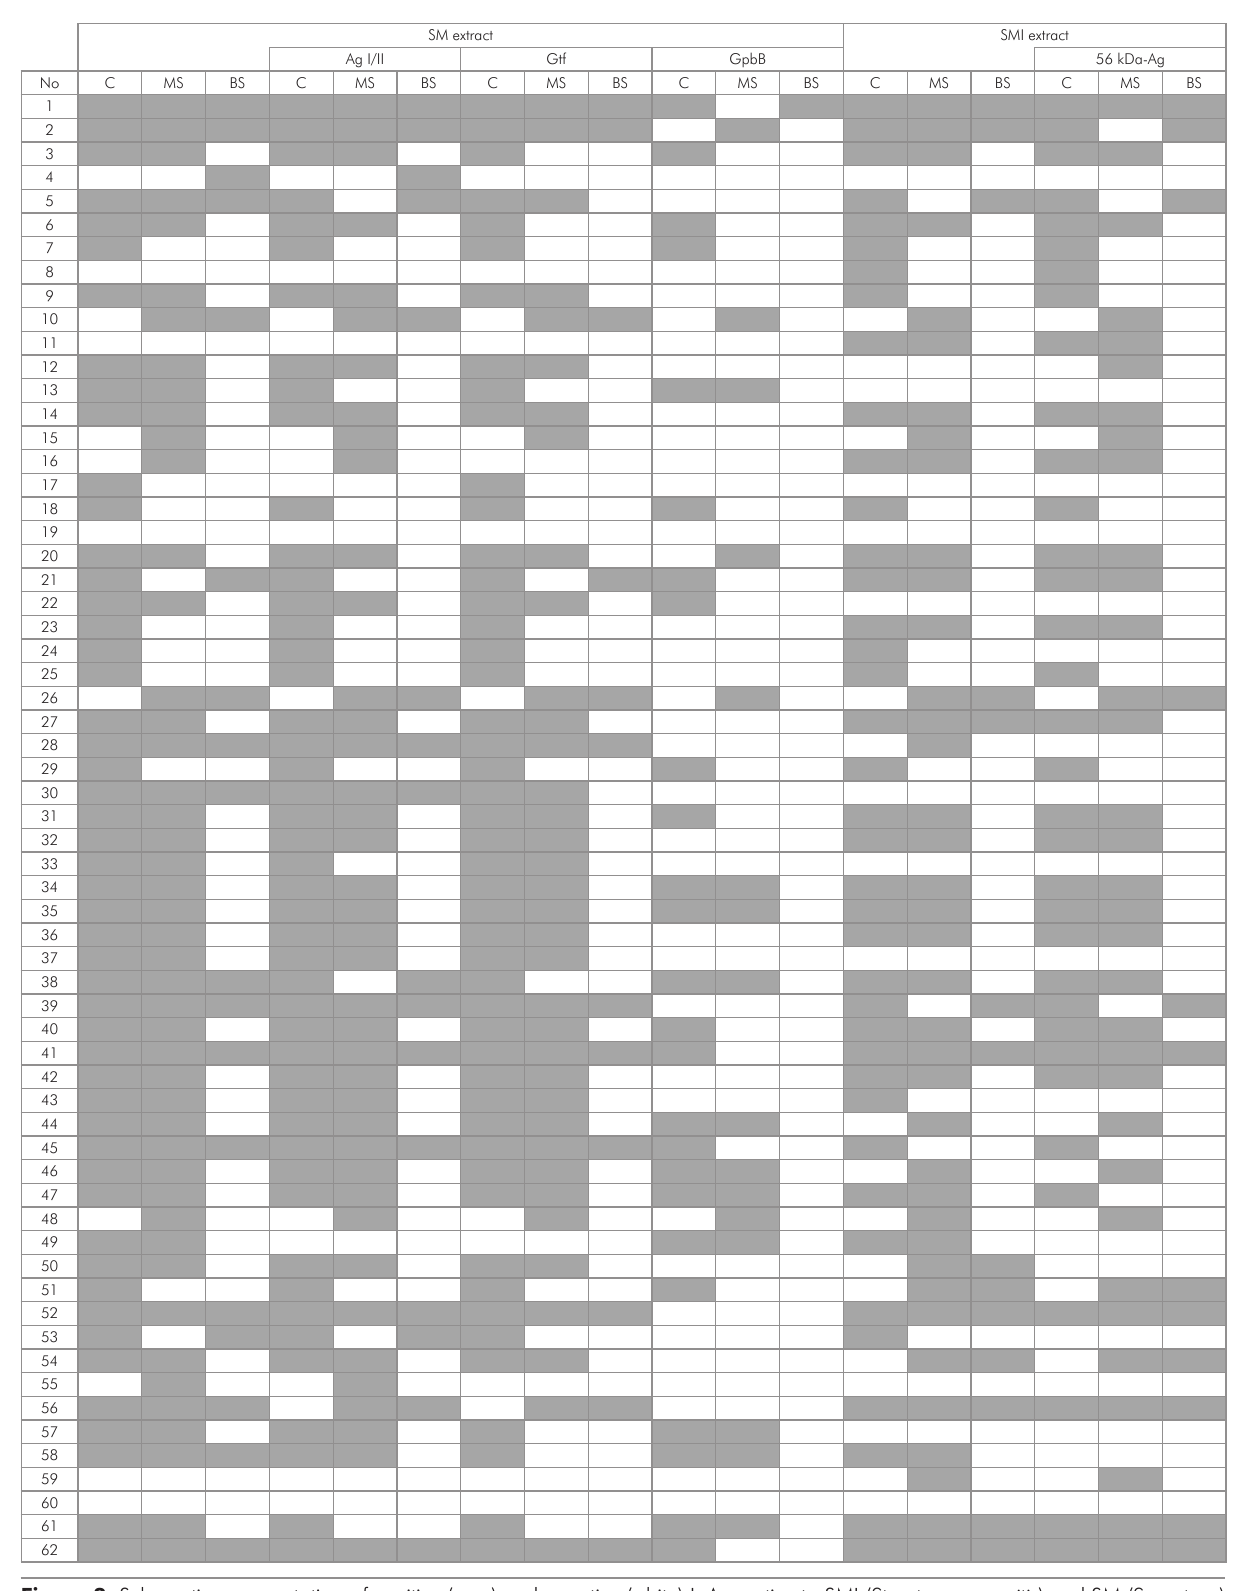
Figure 2. Schematic representation of positive (gray) and negative (white) IgA reactive to SMI ( Streptococcus mitis ) and SM ( S. mutans ) and their virulence antigens (Ag I/II, Gtf, GbpB) in C (colostrum), MS (maternal saliva) and BS (newborn saliva) in the 62 pairs of